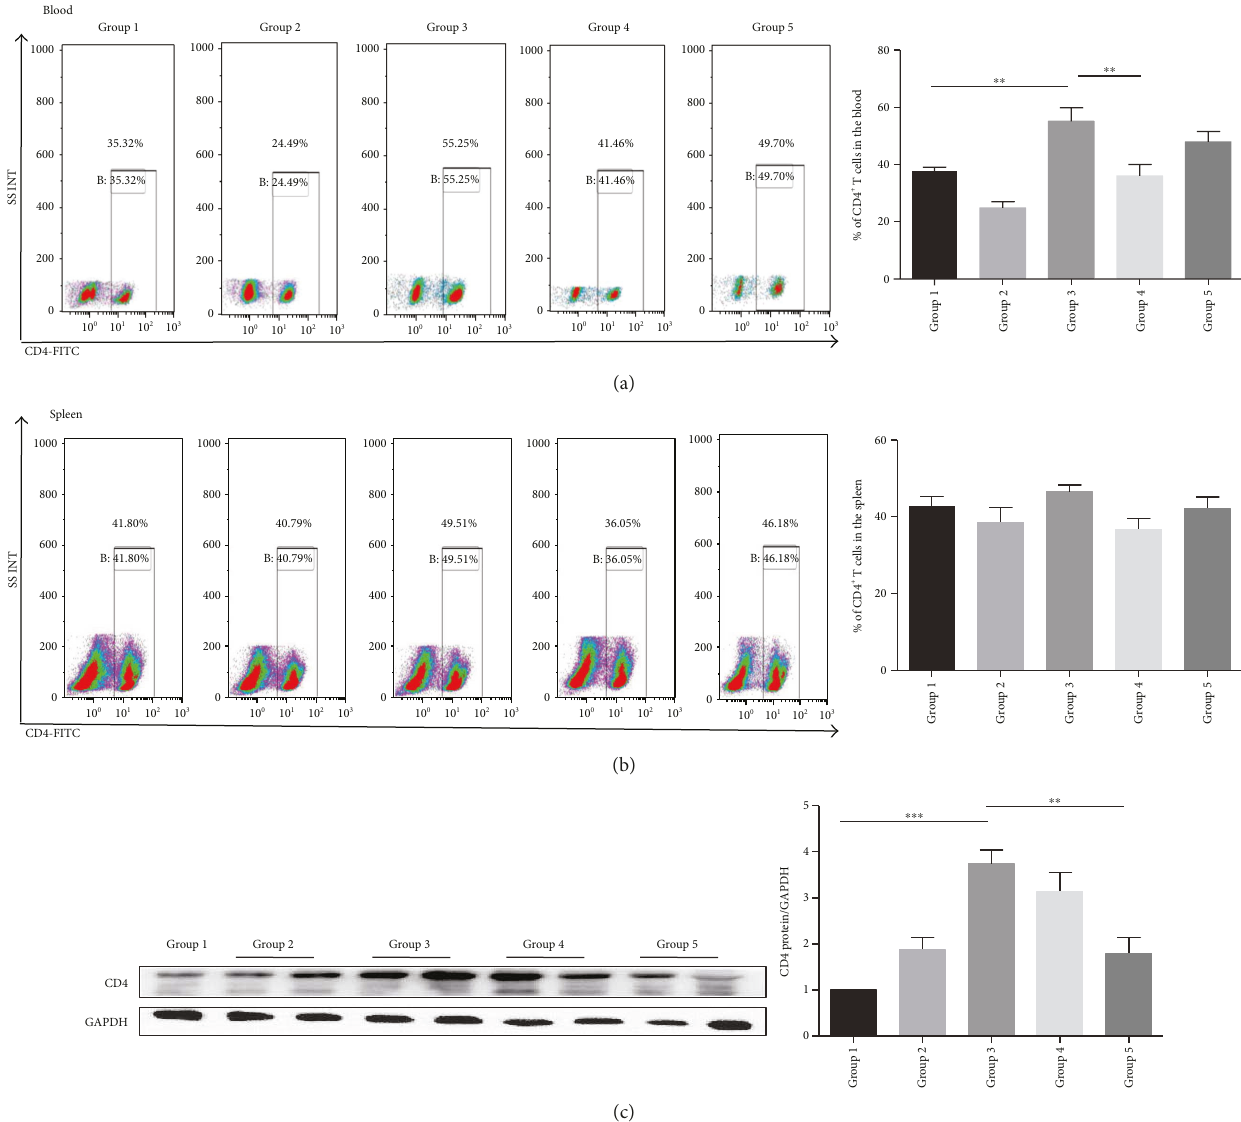
Figure 5: The proportion of total CD4 + T cells in the peripheral blood and spleens in each group. (a) The frequency of CD4 + T cells in the blood. (b) The proportion of total CD4 + T cells in the spleen ( n = 6 – 9/group). The number of Foxp3 + cells in colonic tissues (the white arrows indicate Fox3 + cells) ( n = 6 – 9/group). (c) Western blot analysis of CD4 protein expression levels. Group 1 normal ( n = 3 ); group 2 Bi fi co ( n = 6 ); group 3 colitis ( n = 6 ); group 4 pretreated- Bi fi co -colitis ( n = 6 ); group 5 pretreated+ treated- Bi fi co -colitis ( n = 6 ). Data are means ± SEM . ∗∗ P < 0 01 and ∗∗∗ P < 0 001